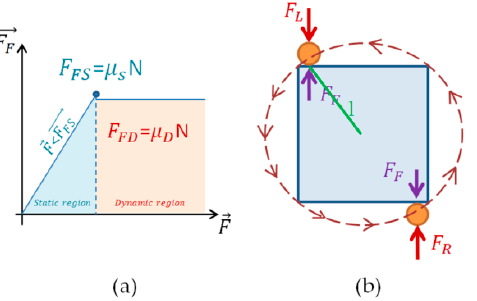
Figure 6. ( a ) Representation of the static and dynamic friction forces in relation to the force needed to start the movement. ( b ) Spinning movement of the box over a surface seen from above.